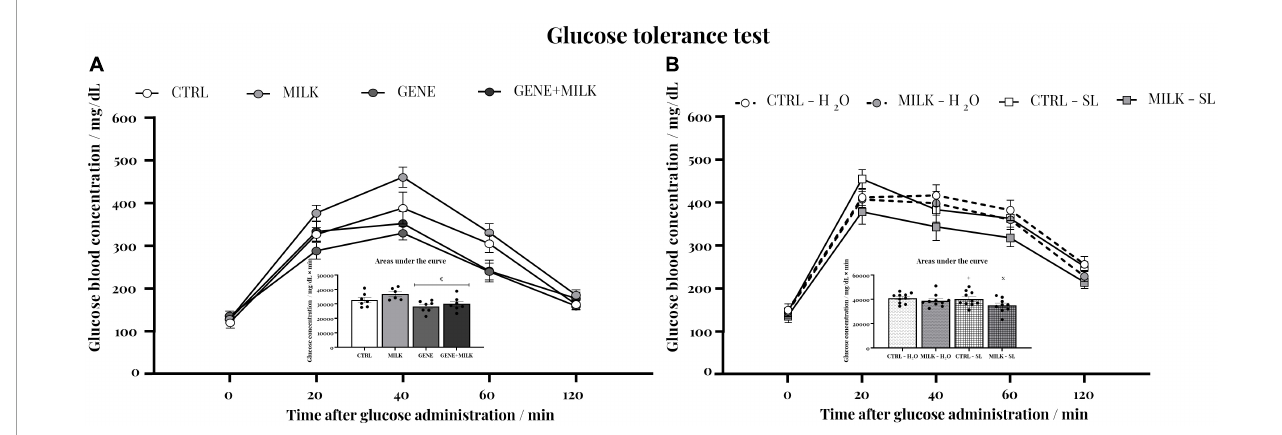
FIGURE6 Glucose tolerance test: blood glucose concentrations before and after a glucose (2 g/kg body weight) injection in experiment 1 (A) and experiment 2 (B) ; inset: integral response to glucose administration plotted as the area under the curve. € p < 0.05 in post-hoc tests compared MILK group. × p < 0.05 in post-hoc tests compared to CTRL – H 2 O group; + p < 0.05 in post-hoc tests compared to MILK – SL group.